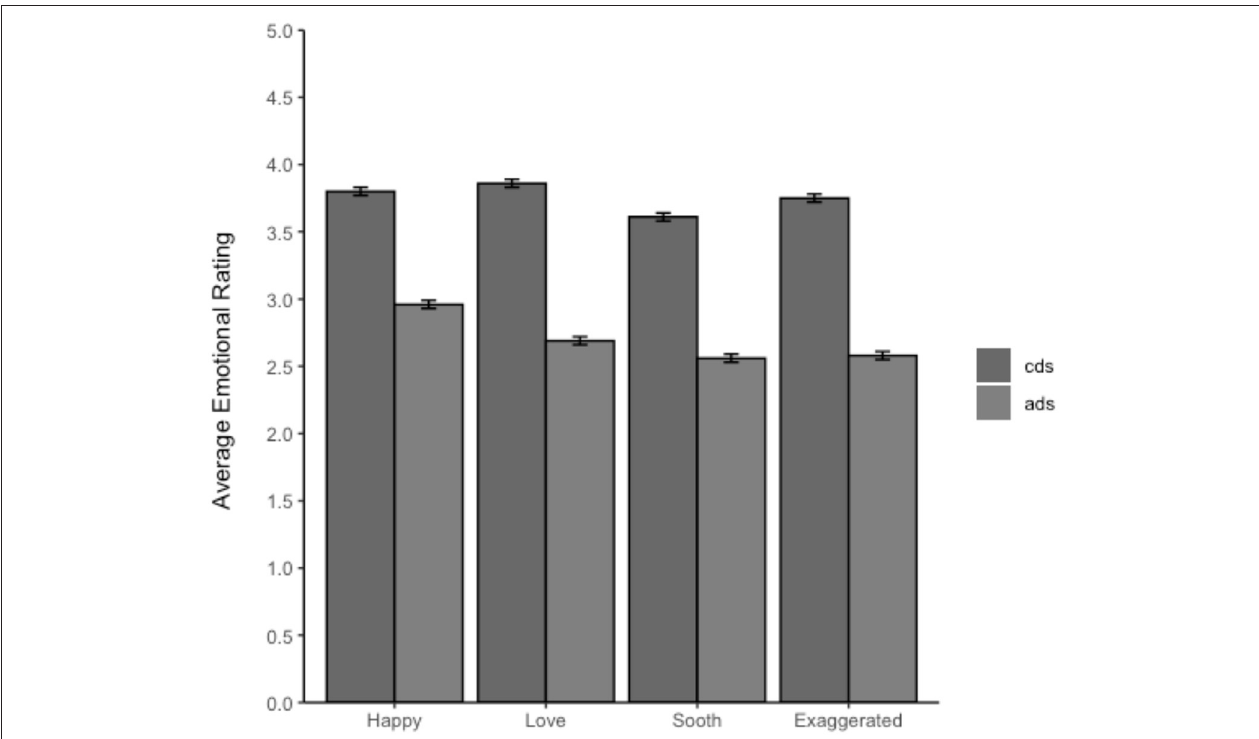
FIGURE 1 | Average rating of each of the positive affect measures by addressee. The error bars represent the 95% CIs. The rating scale was 1–5 with 1 being “ extremely not sounding ” like that emotion, 3 being neutral, and 5 being “ sounded extremely ” like that emotion. Thus, average ratings > 3 suggest a tendency to rate the speech as containing this emotion and values < 3 suggest the speech was rated as not sounding like that emotion.